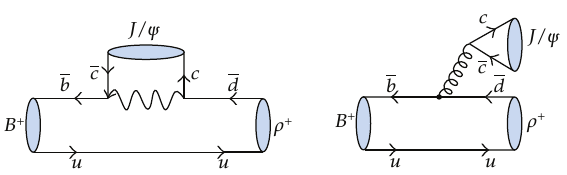
Figure 1: The Feynman diagrams contributing to the B (cid:2) → J/ψρ (cid:2)